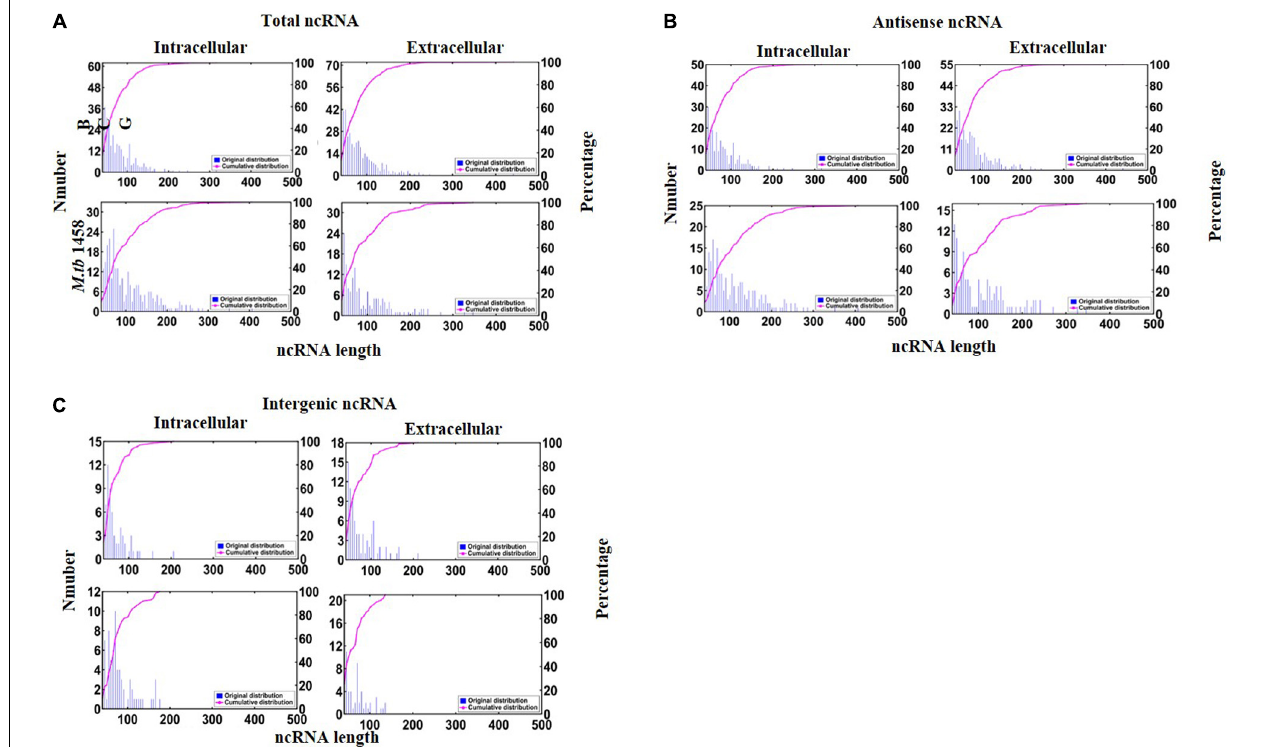
FIGURE 1 | Distribution of ncRNA length: (A) total, (B) antisense, and (C) intergenic ncRNAs.